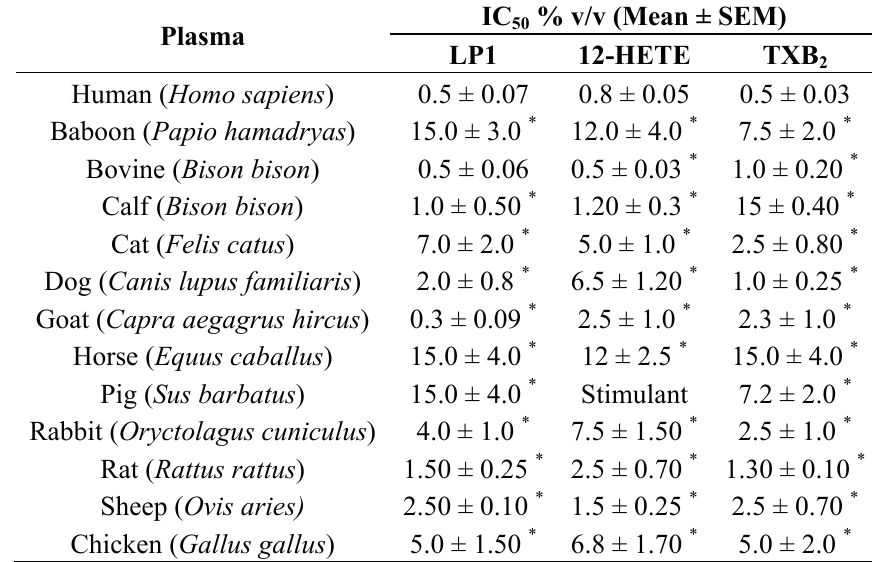
Table 1. Comparative effects of plasma obtained from different mammalian species